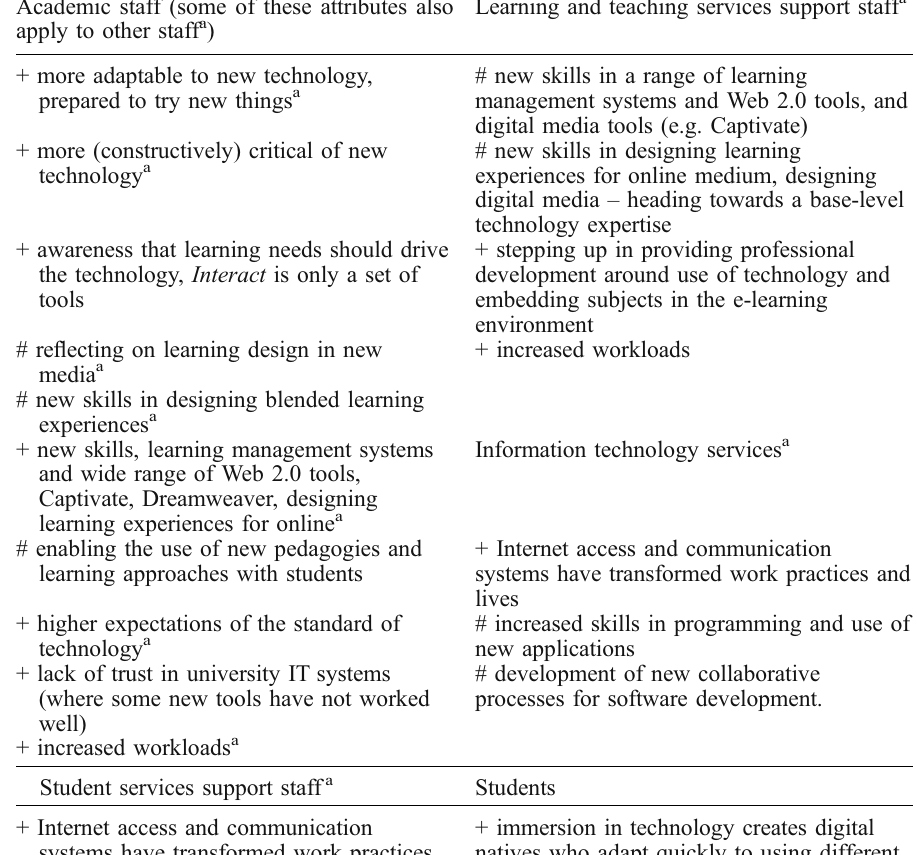
Table 1. Summary of transformational impacts of learning technology at individual level